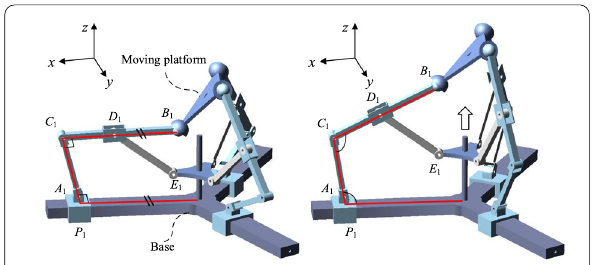
Figure 20 Increasing the height of the lifting platform to avoid singularity at the singular position